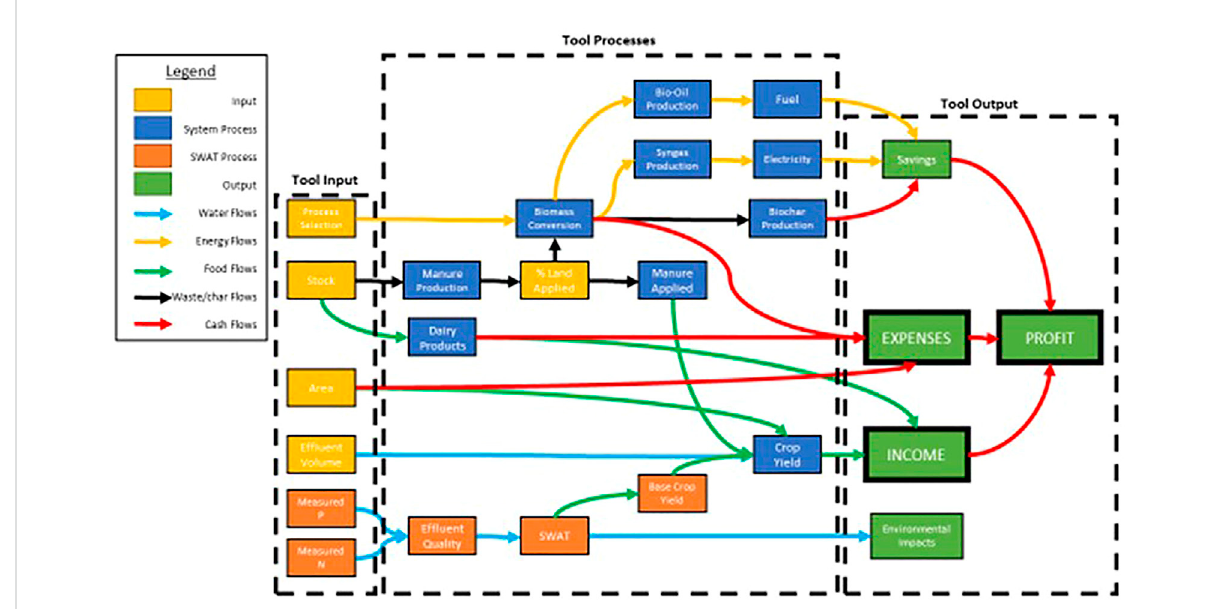
FIGURE 3 The nexus tool framework for Southwest Regional Dairy Farm. Inputs, resources fl ow and calculations, and outputs in the dairy system.